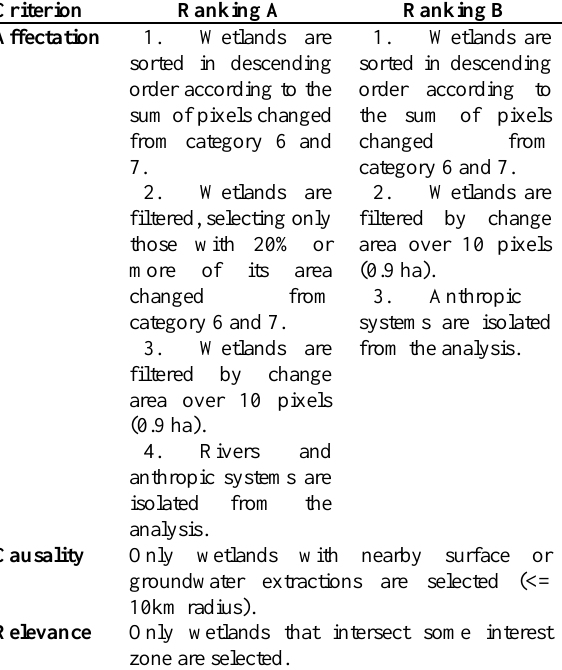
Table 4. Criteria for ranking generation.